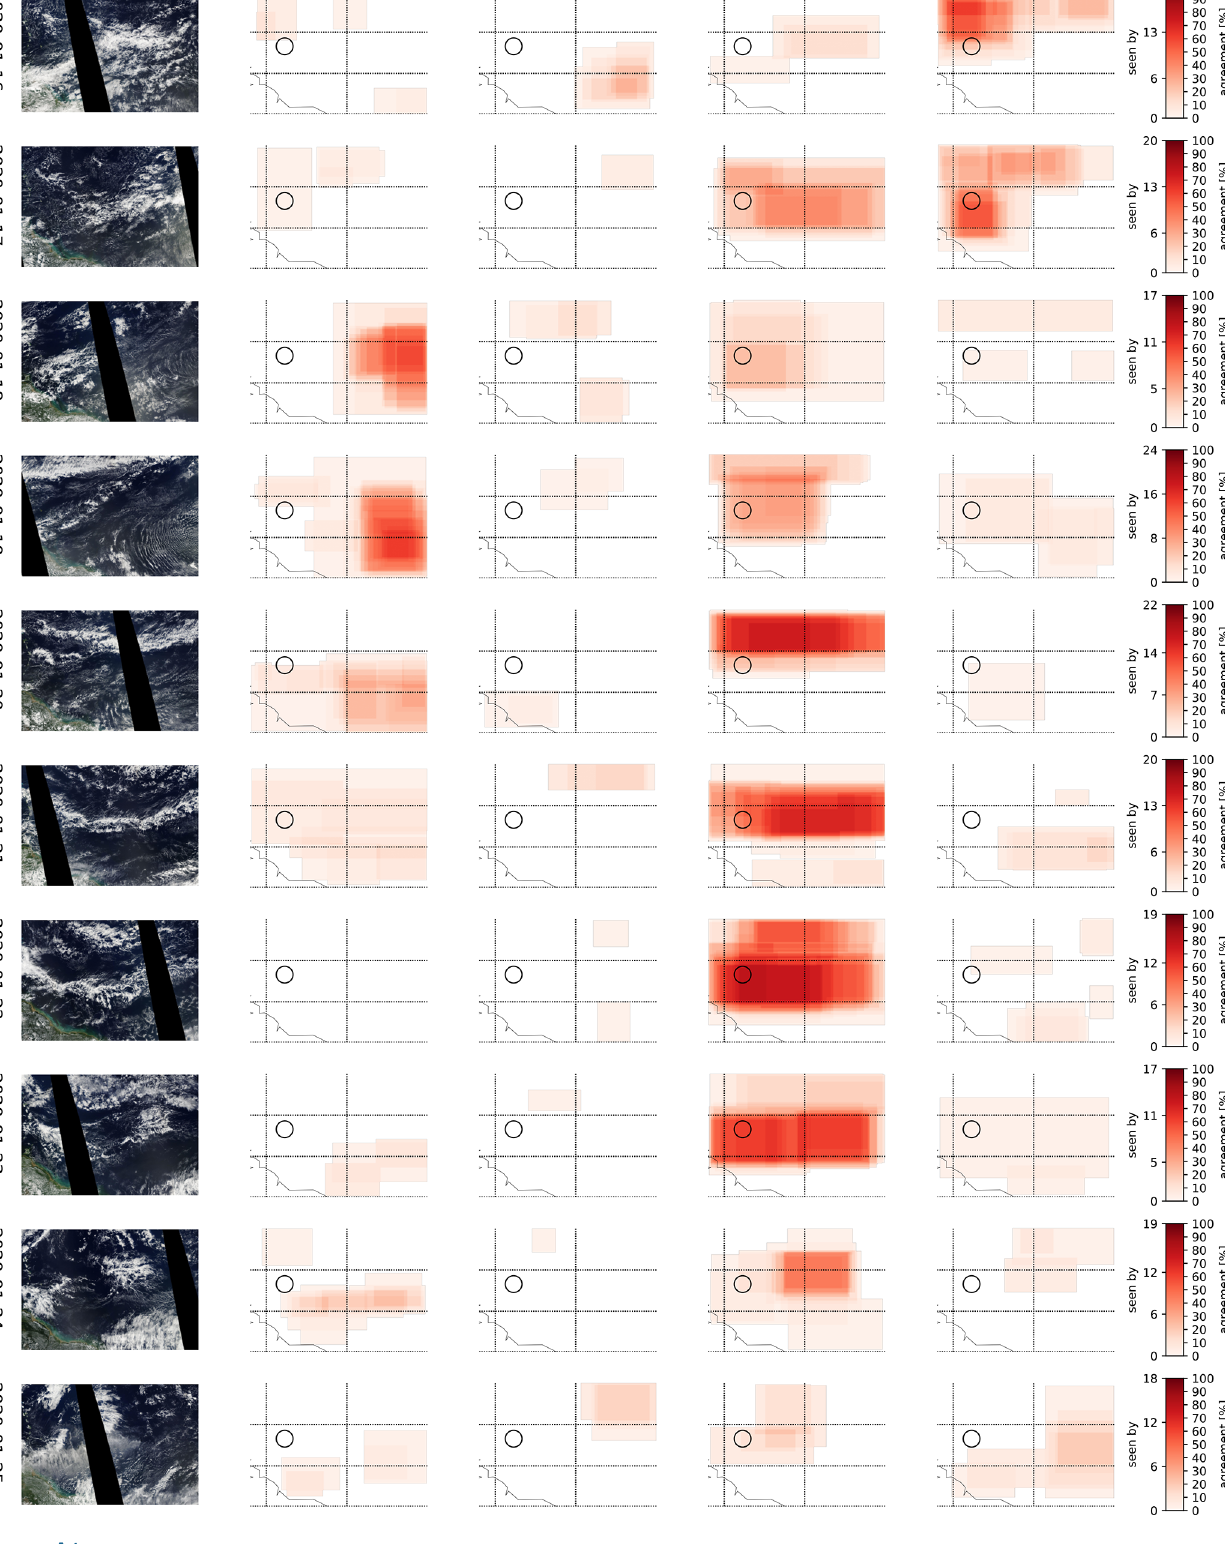
Earth Syst. Sci. Data, 14, 1233–1256,